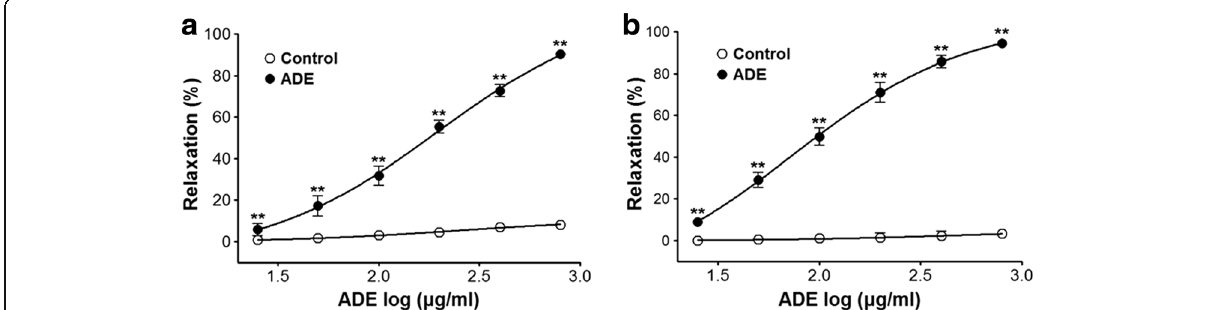
Fig. 1 Relaxation effect of ADE (25 – 800 μ g/mL) on PE (1 μ M) ( a ) or KCl (60 mM) ( b )-precontracted aortic rings. Values are expressed as the mean ± SEM ( n = 5 – 8, number of aortic rings). ** P < 0.01 vs.